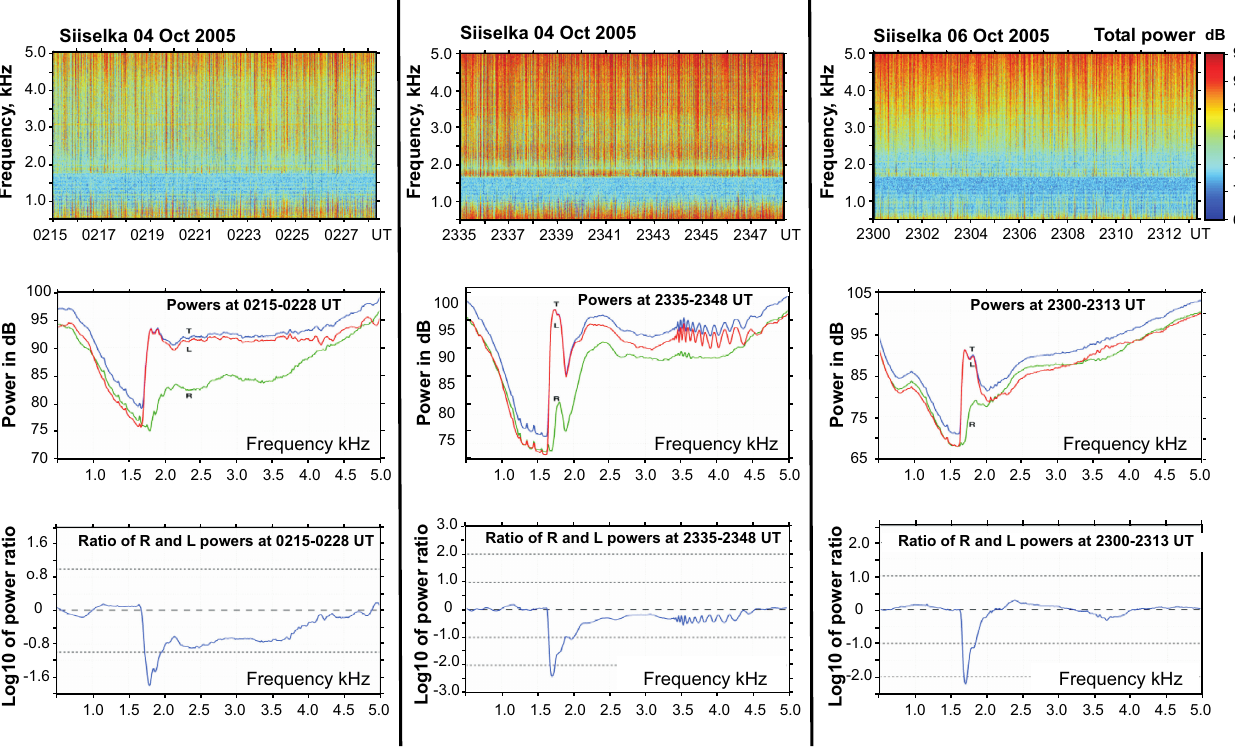
Fig. 2. Typical night-time sferics recorded at the Siselka station during the September–October 2005 campaign. Upper panels show the spectrograms of the total ELF-VLF power at frequencies below 5kHz. Middle panels depict the power spectra integrated over 13min < each of them corresponds to the spectrograms shown by the upper panels. The letters T, L, and R denote the total (blue), the LHP (red), and the RHP (green) power spectra. Bottom plots show the ratio of the LHP to the RHP power. At the Earth-ionosphere waveguide cut-off and just above (1.6–1.8kHz), the perfect left-hand circular polarization